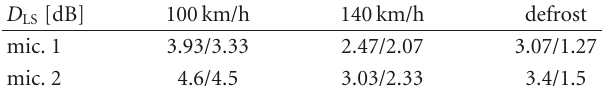
Table 2: Log spectral distances with minimum statistics noise PSD estimation and with the proposed noise PSD